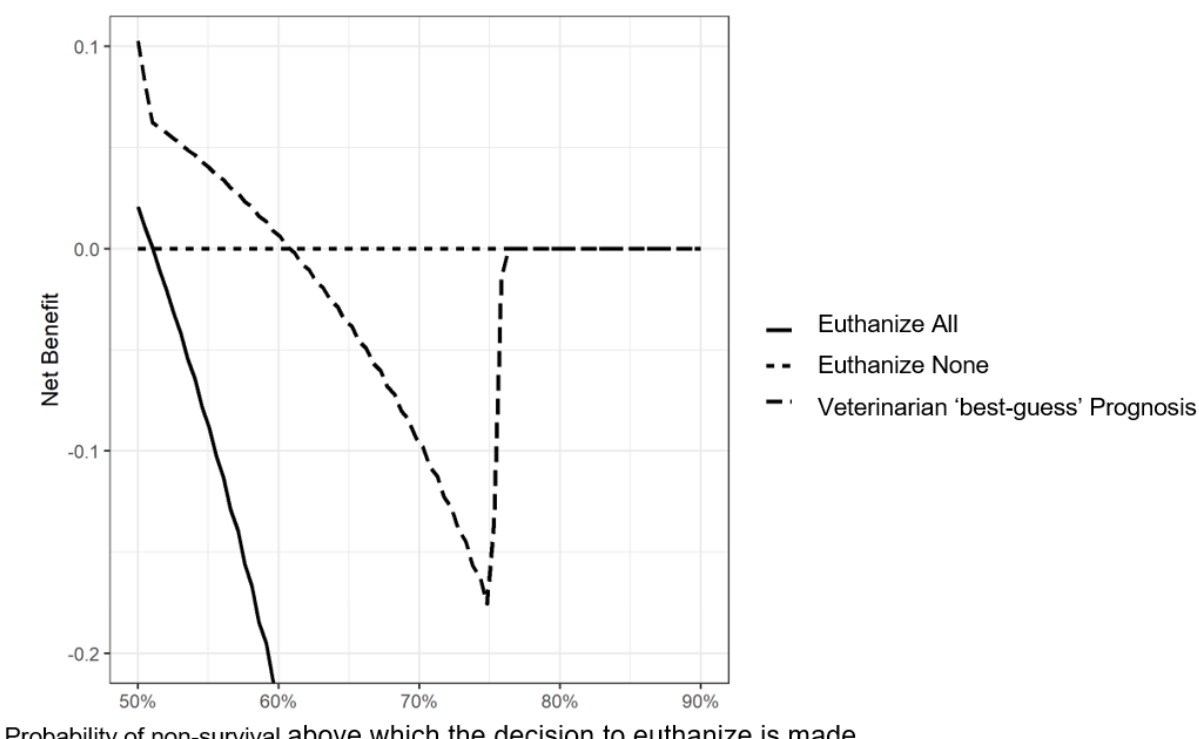
Figure 8. Decision curve analysis of veterinarian “best-guess” prognosis of dairy cows coming from 124 herds in Québec, Canada with severe clinical mastitis in the 60-day period following a veterinary clinical evaluation.